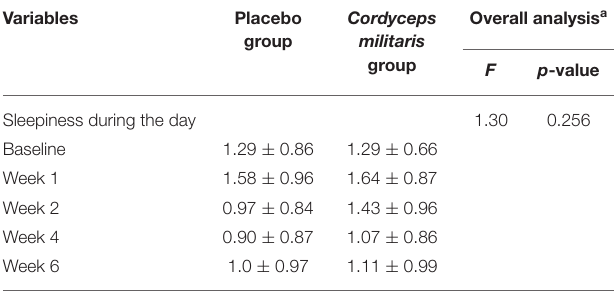
TABLE 2 | Changes of AIS factors and total scores at baseline, week 1, week 2, week 4, and week